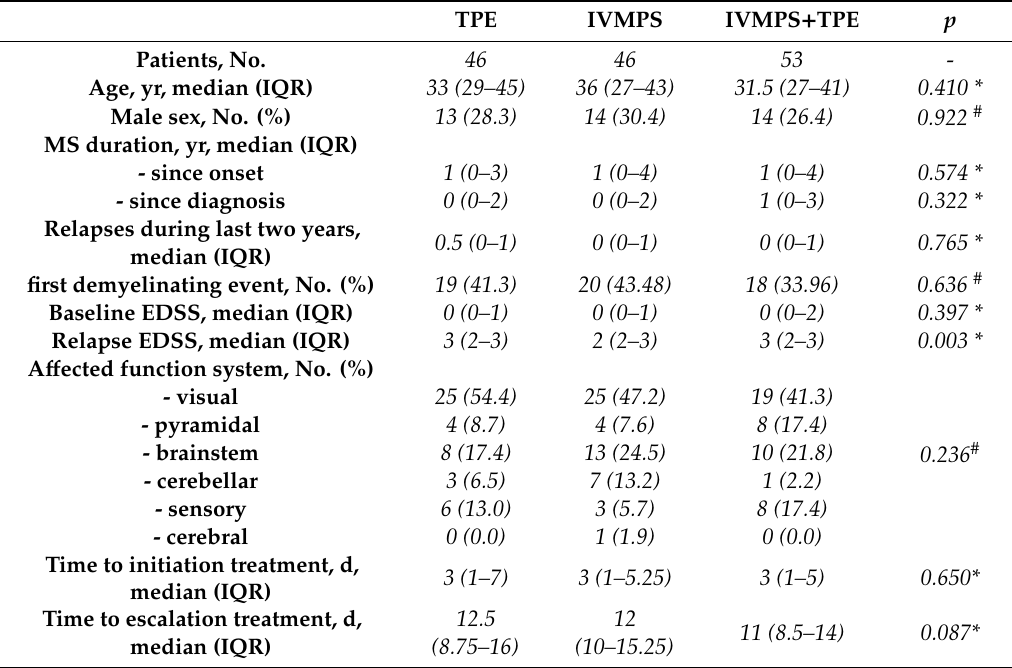
Table 1. Rescue therapy patient baseline and follow-up characteristics compared between treatment